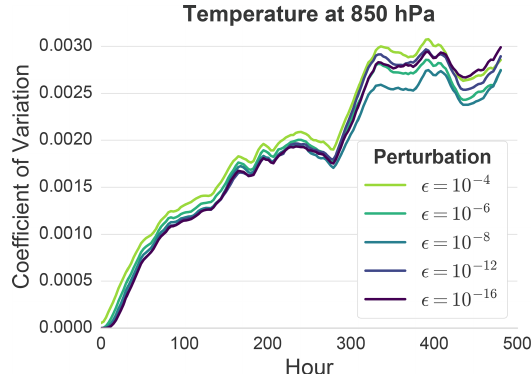
Figure A1. Mean coefficient of variation averaged over all grid points of 850hPa temperature from ensembles (50 members per ensemble) with different initial perturbation magnitudes accord- ing to Eq. (3). The relatively strong perturbation used in this work ( (cid:15) = 10 − 4 ) leads to only a slightly higher variance during the first few days than a perturbation at machine precision ( (cid:15) = 10 − 16